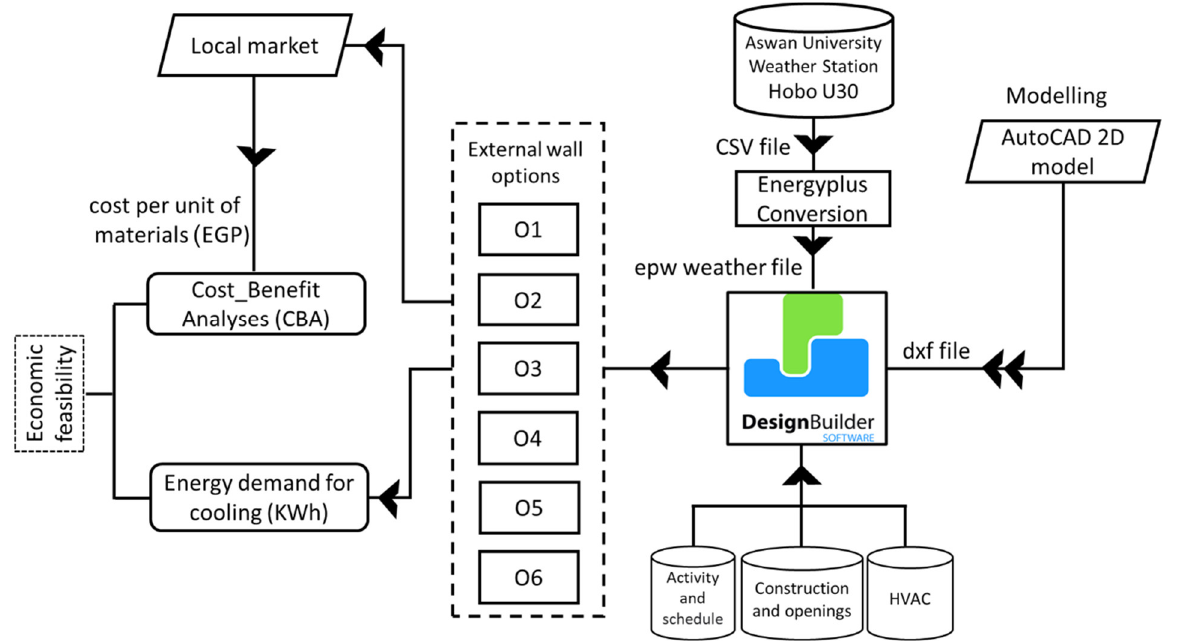
Figure 3. Schematic diagram of the study framework.